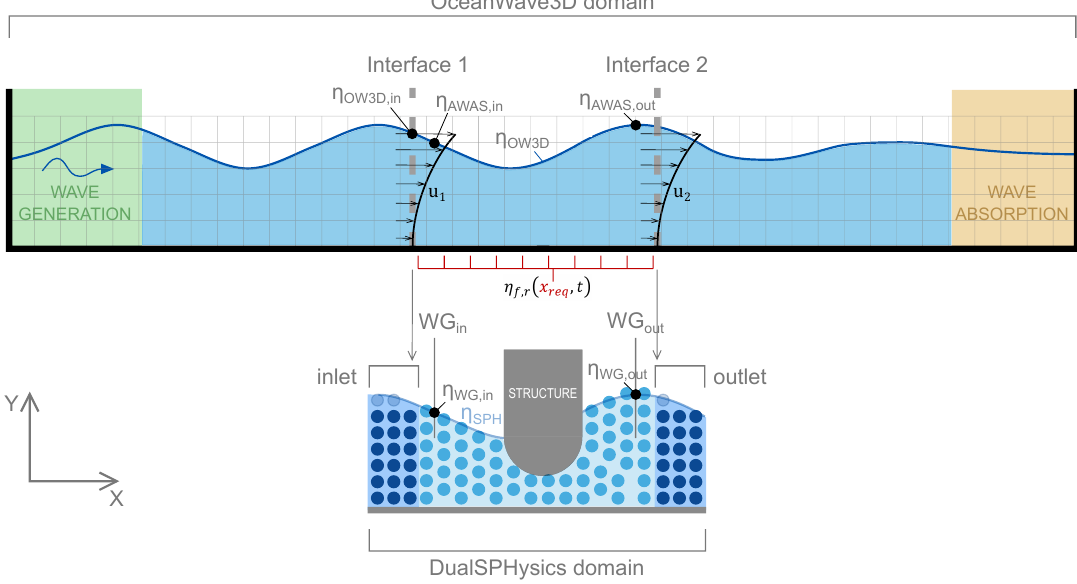
Figure 2. General sketch of coupling methodology between the OceanWave3D domain ( top ) and the DualSPHysics domain ( bottom